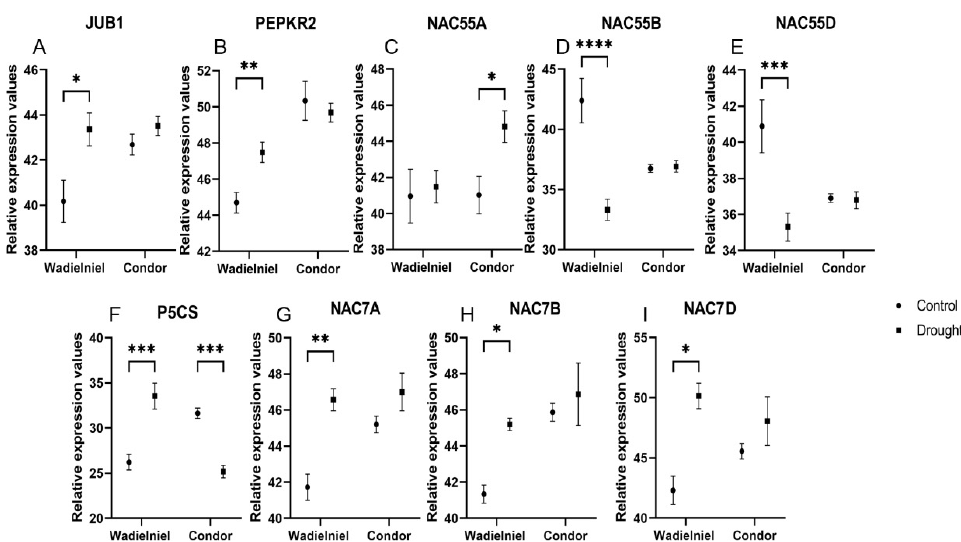
Figure 4. Relative expression data for selected genes studied by qRT-PCR. ( A – I ) Wheat genes selected for expression analysis. The primers used are listed in Table S2. The Y axis indicates expression level (40- Δ Ct). Values are expressed between an arbitrary value of 40 and Δ CT, so a high 40- Δ Ct value indicates a higher expression level. Statistical significances were determined with a Student t -test versus the control in the same cultivar. * p < 0.05, ** p < 0.01, *** p < 0.001, **** p < 0.0001.